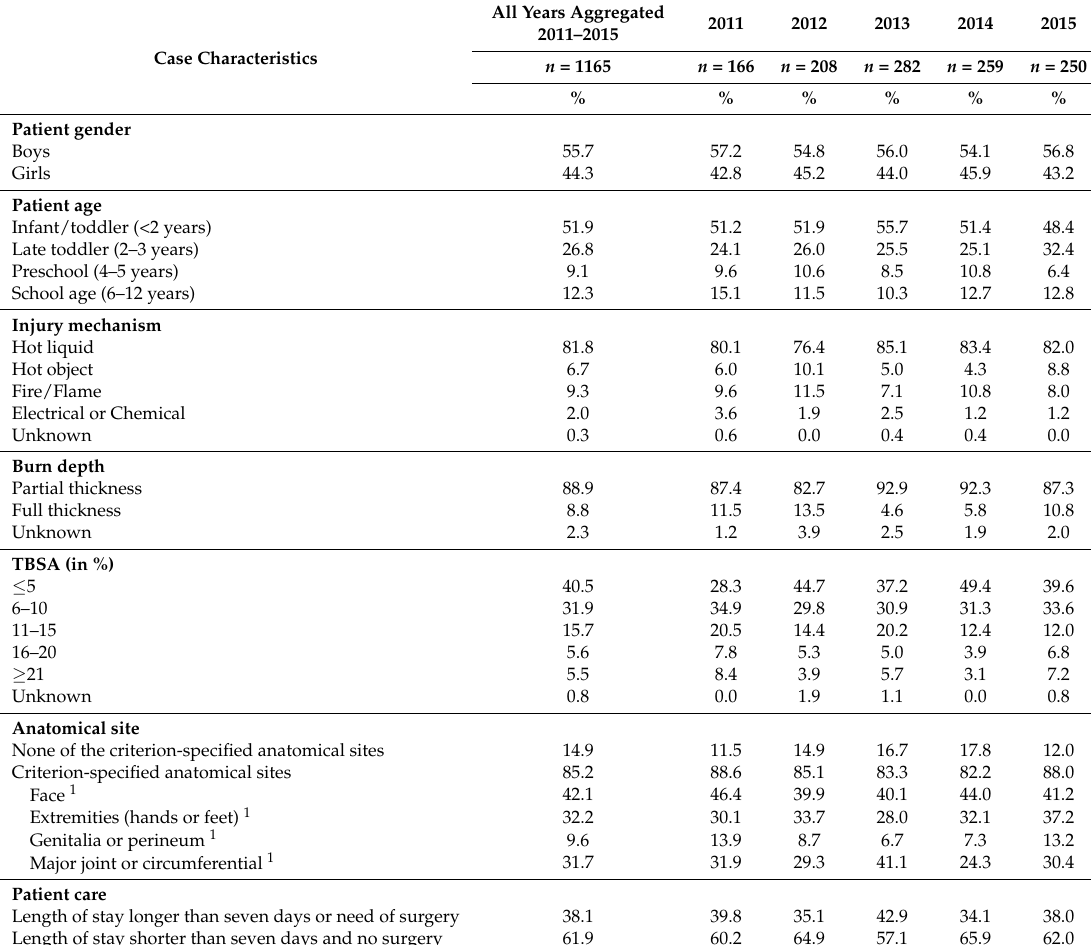
Table 1. Description of the characteristics of the cases, including patient, injury, and treatment, for all years aggregated and by year of